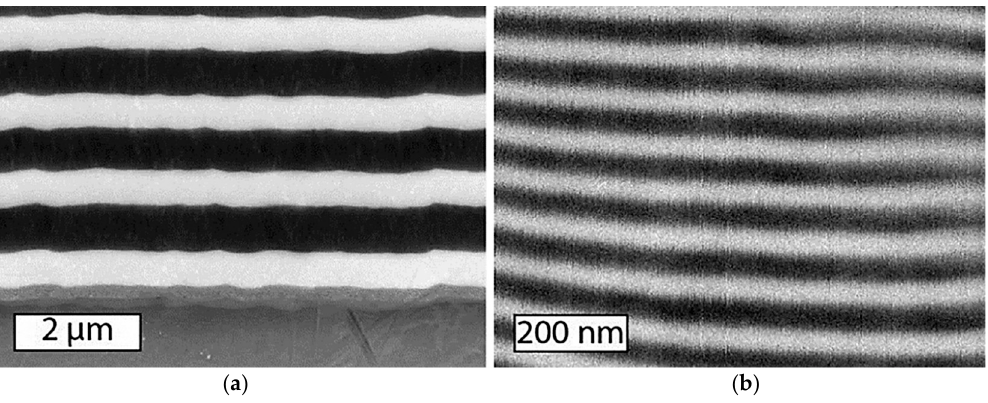
Figure 9. SEM images of CrN/MoN coatings with bilayer thickness of ( a ) 1.18 μ m and ( b ) 44 nm. Reprinted with permission from [126] 2017 Elsevier.